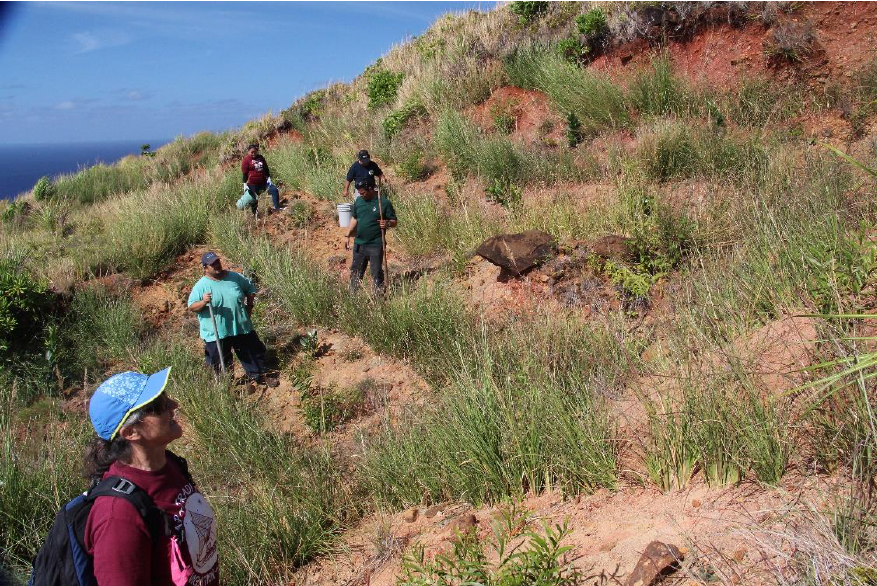
Figure 4. Planting Acacia confusa and vetiver grass on an eroded Oxisol on the island of Rota, Commonwealth of the Northern Marianas Islands.